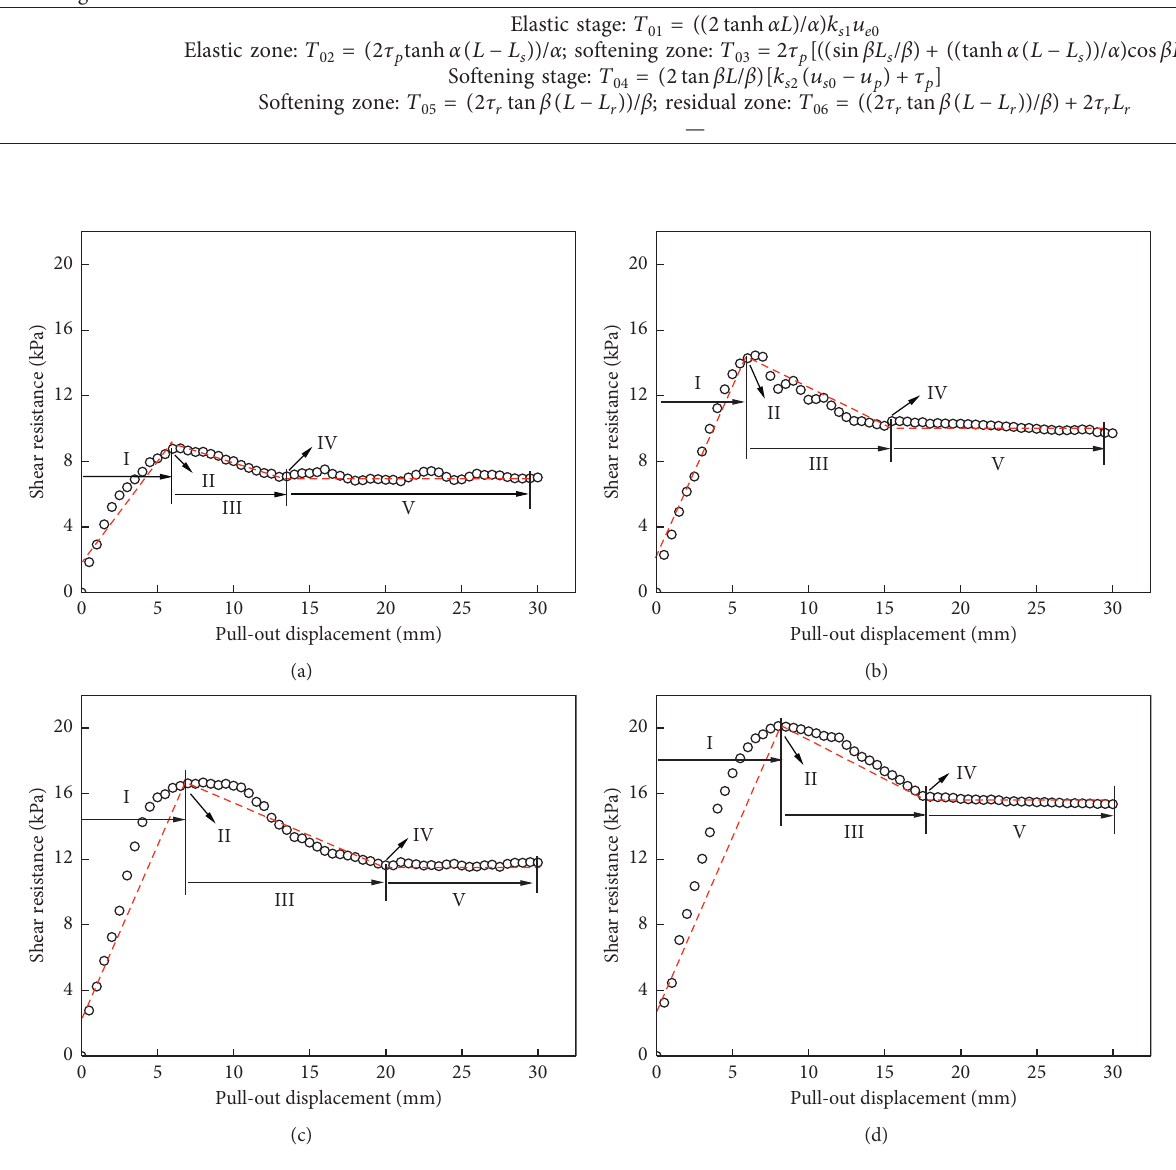
Figure 19: Comparison between the pull-out test results and model-predicted results of geotextiles under different normal